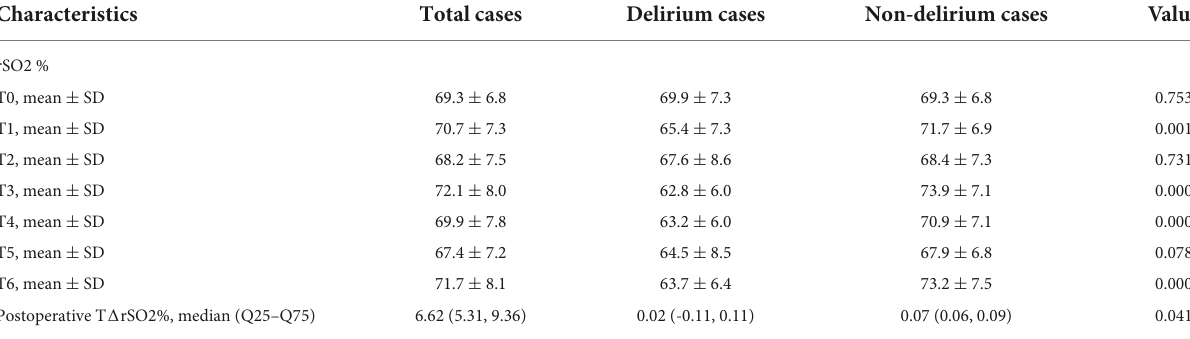
TABLE 2 Local cerebral oxygen saturation (rSO2) values at different time